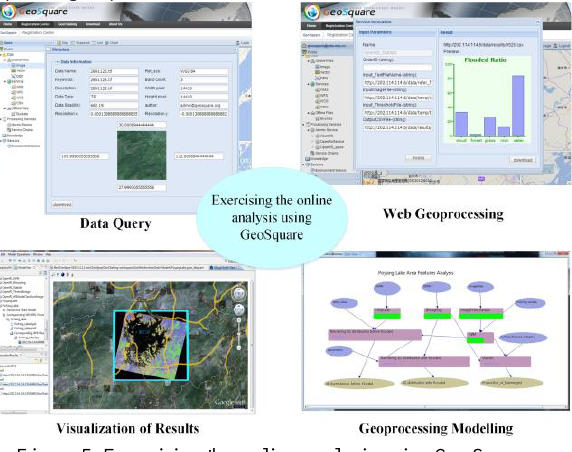
Figure 5. Exercising the online annlysis using